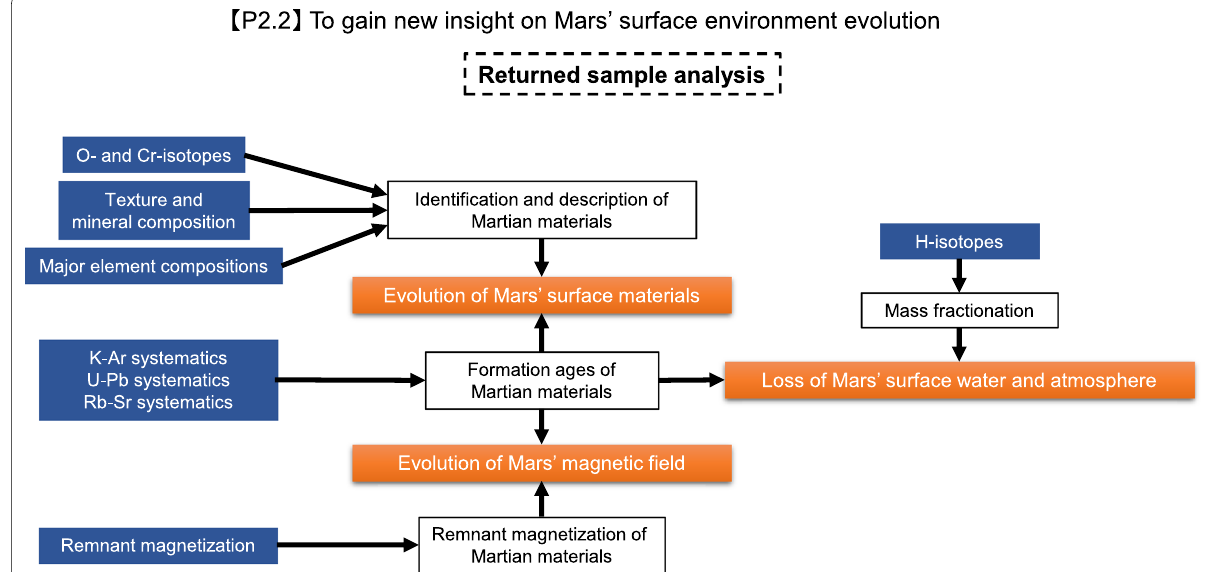
Fig. 5 Flowchart of sample analyses together with remote sensing observations to understand the surface evolution of Mars (objective 2.2 in Table